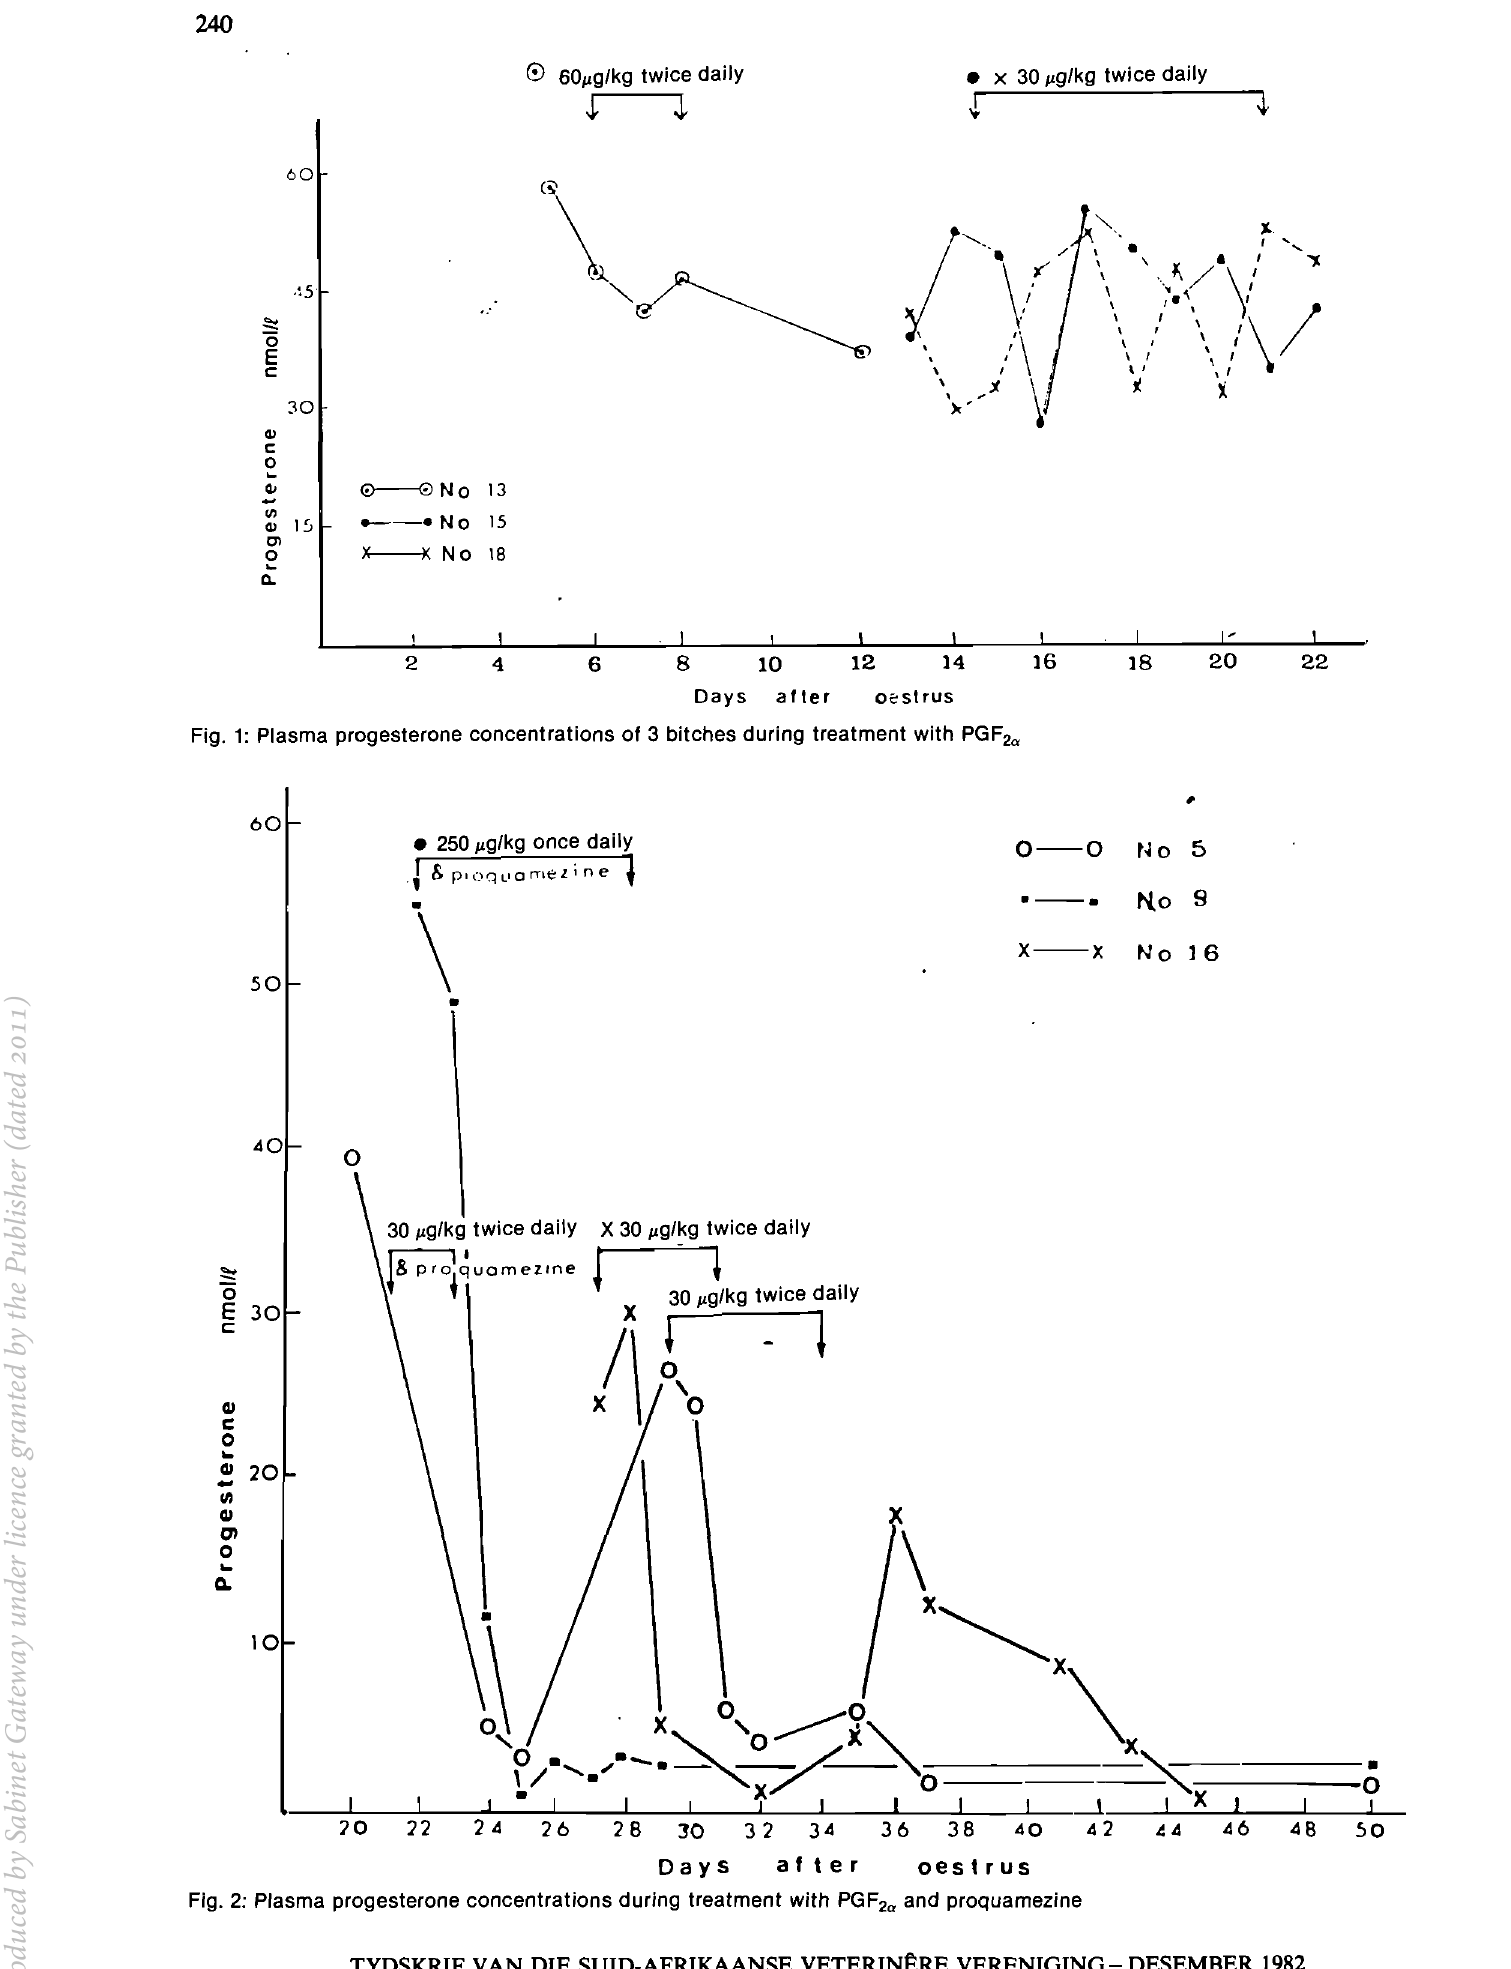
Fig. 2: Plasma progesterone concentrations during treatment with PGF 2a and proquamezine TYDSKRIF VAN DIE SUID-AFRIKAANSE VETERIN~RE VERENIGING- DESEMBER